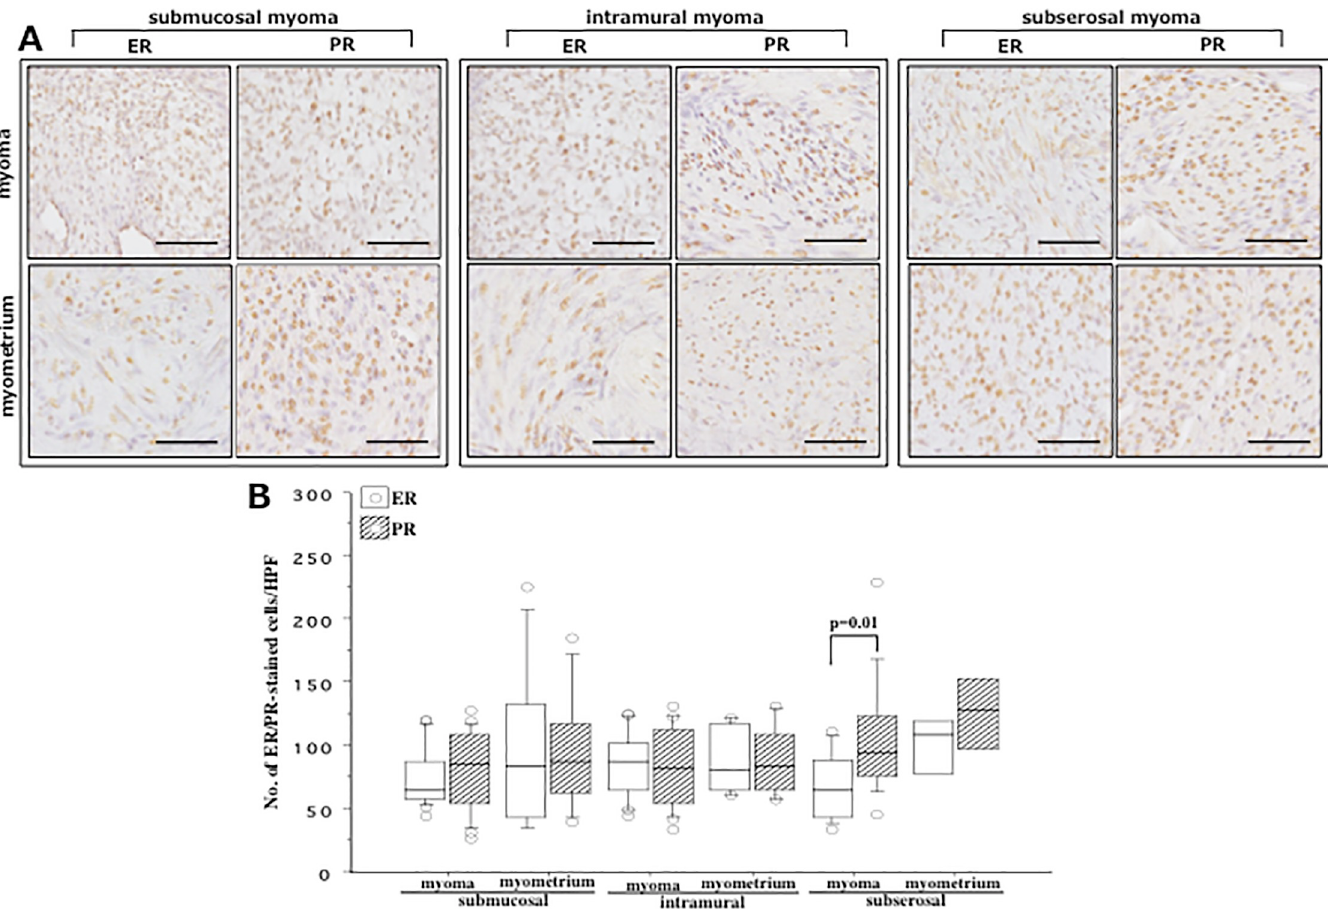
Fig 1. (A) Immunohistochemical staining of estrogen receptor (ER) and progesterone receptor (PR) in smooth muscle cells (SMCs) detected in biopsy samples derived from myoma (upper row) and adjacent myometria (lower row) of women with submucosal myoma (left panel), intramural myoma (middle panel) and subserosal myoma (right panel). (B) Shows number of estrogen receptor (ER, white box)- and progesterone receptor (PR, hatched box)-immunostained cells in myoma and myometria derived from these three groups of women. Scale bar = 50 μ m and 100 μ m for slides of ( A ). Comparing to ER, PR expression was significantly higher in fibroid tissue derived from women with subserosal myoma (p = 0.01). The boxes represent the interquartile ranges and horizontal lines in the boxes represent median values. HPF, high power field